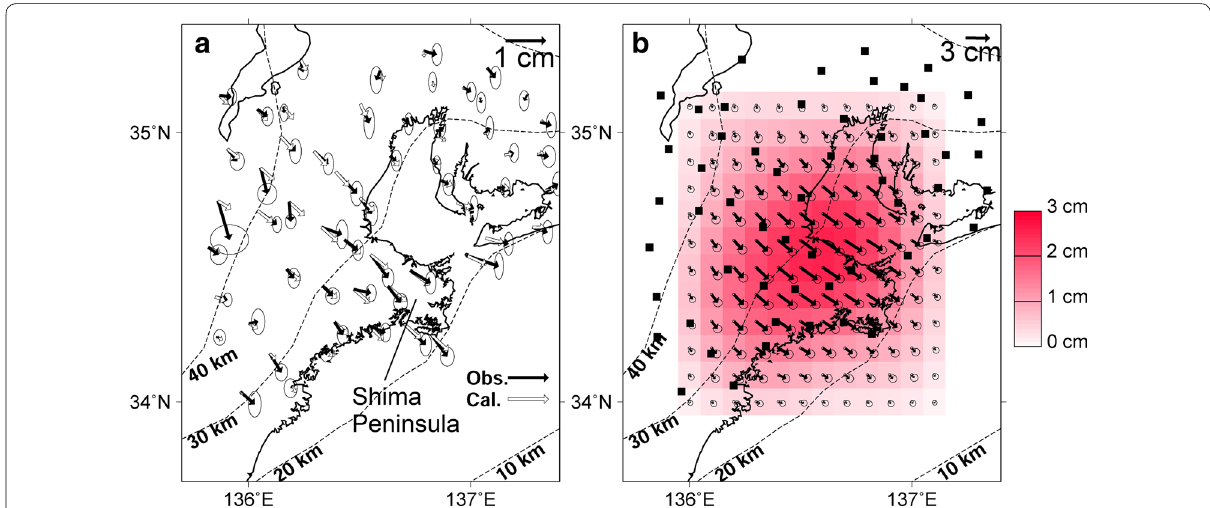
Fig. 3 Map of the Shima Peninsula showing horizontal unsteady displacement and estimated slip distribution. a Horizontal displacements for the period April 2017 to October 2018 used for estimating fault slip. Black arrows indicate observations, and white arrows indicate calculated values. Ellipses at the tips of the black arrows show standard deviations of the coordinates. b Estimated slip distribution on the plate interface. Arrows indicate the motion of the overriding plate with respect to the subducting Philippine Sea plate. Ellipses at the tips of the arrows indicate estimation errors. Solid squares are locations of GNSS stations. Dashed contours show the depth of the top of the subducting plate (Hirose et al.